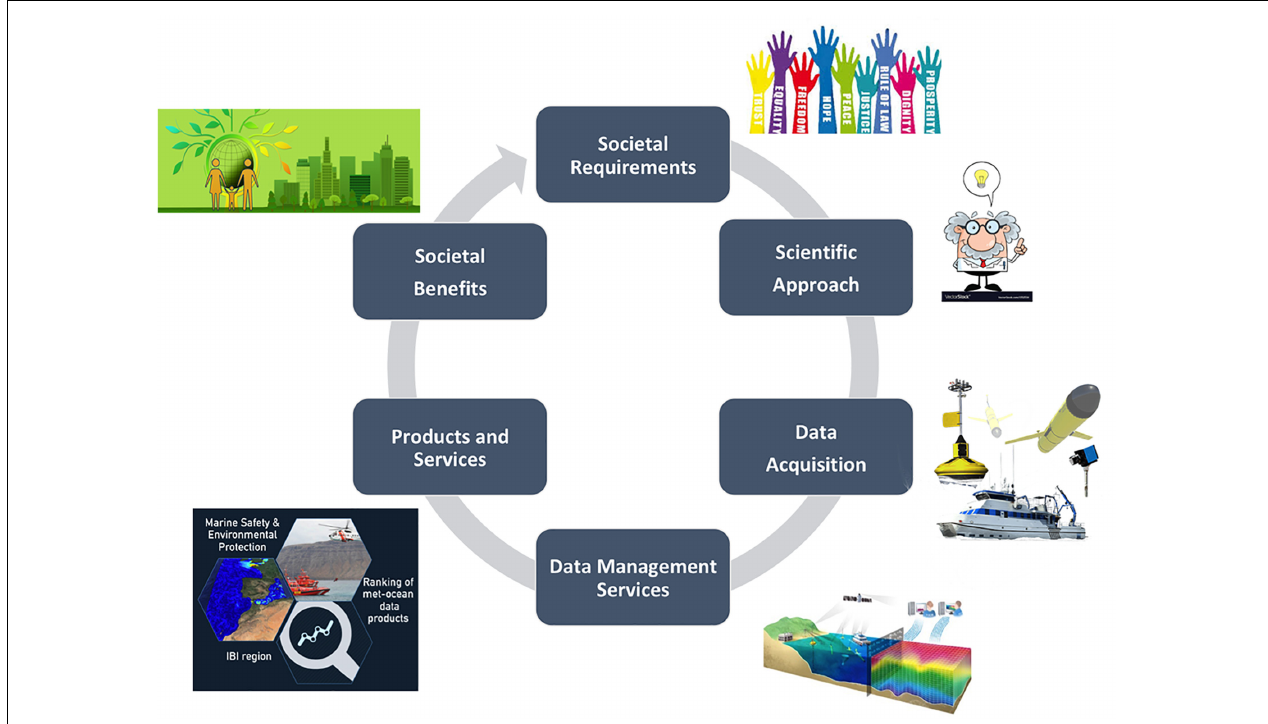
FIGURE 1 | Ocean observing value chain from requirements to societal